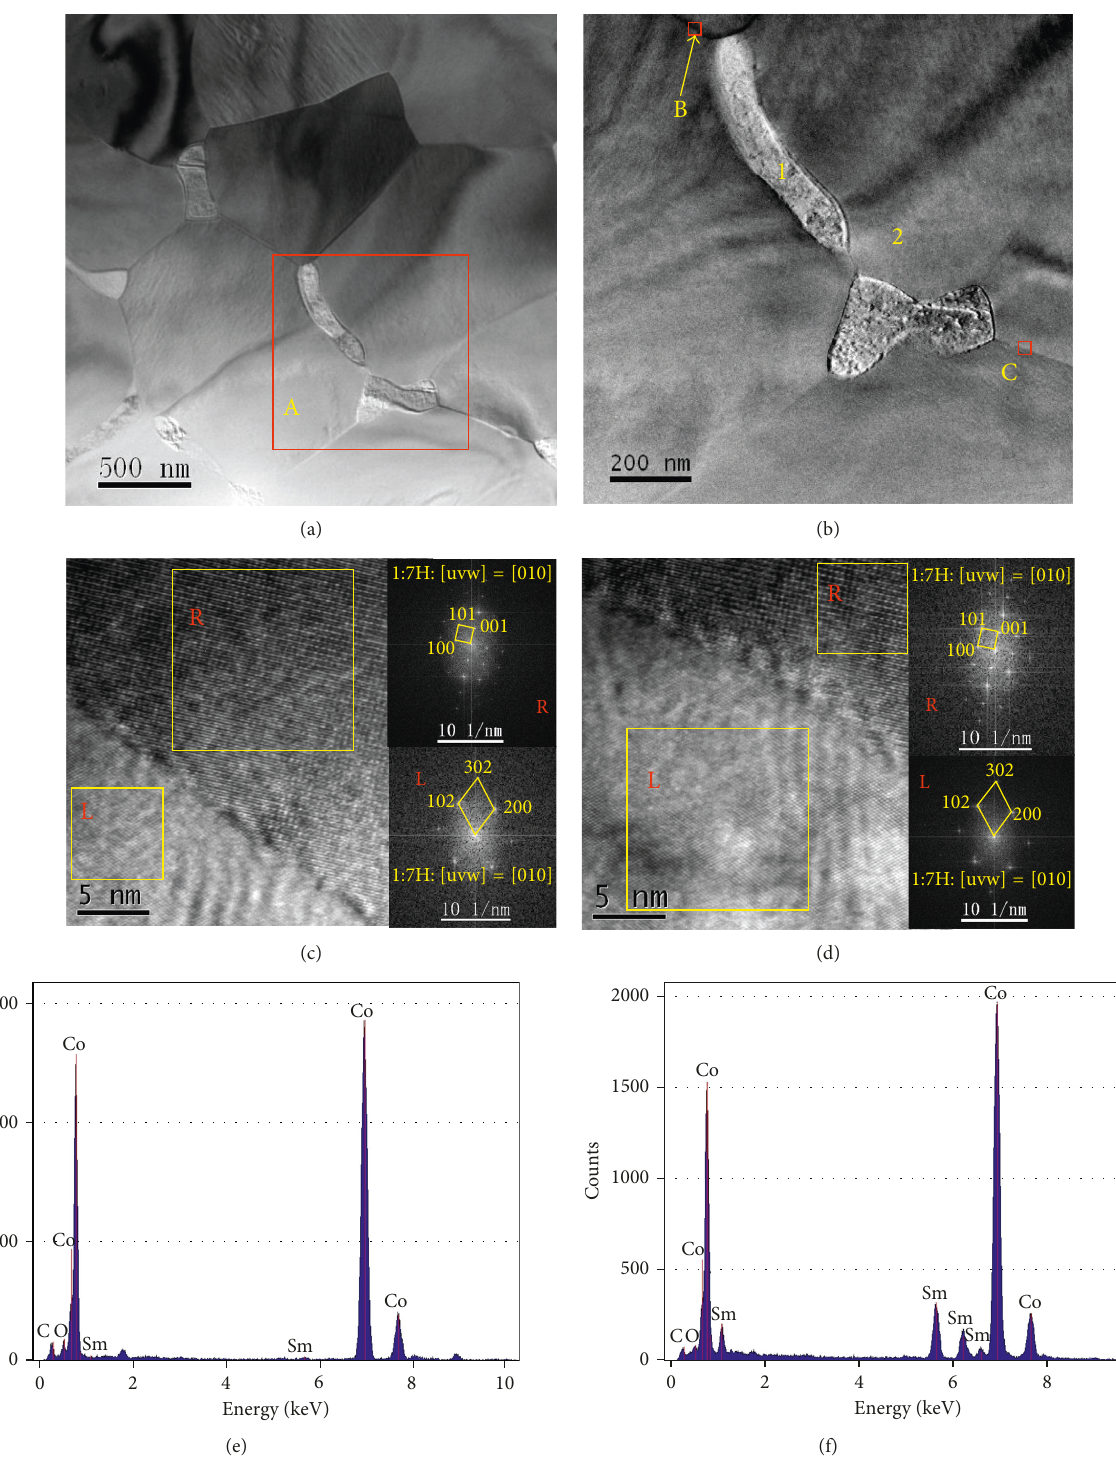
Figure 3: TEM images and EDS spectra of as-spun ribbons. (a) TEM image. (b) Amplified image of region A in (a). (c) Amplified image of region B in (b). (d) Amplified image of region C in (b). (e) Energy spectrum of Position 1 in (b). (f) Energy spectrum of Position 2 in